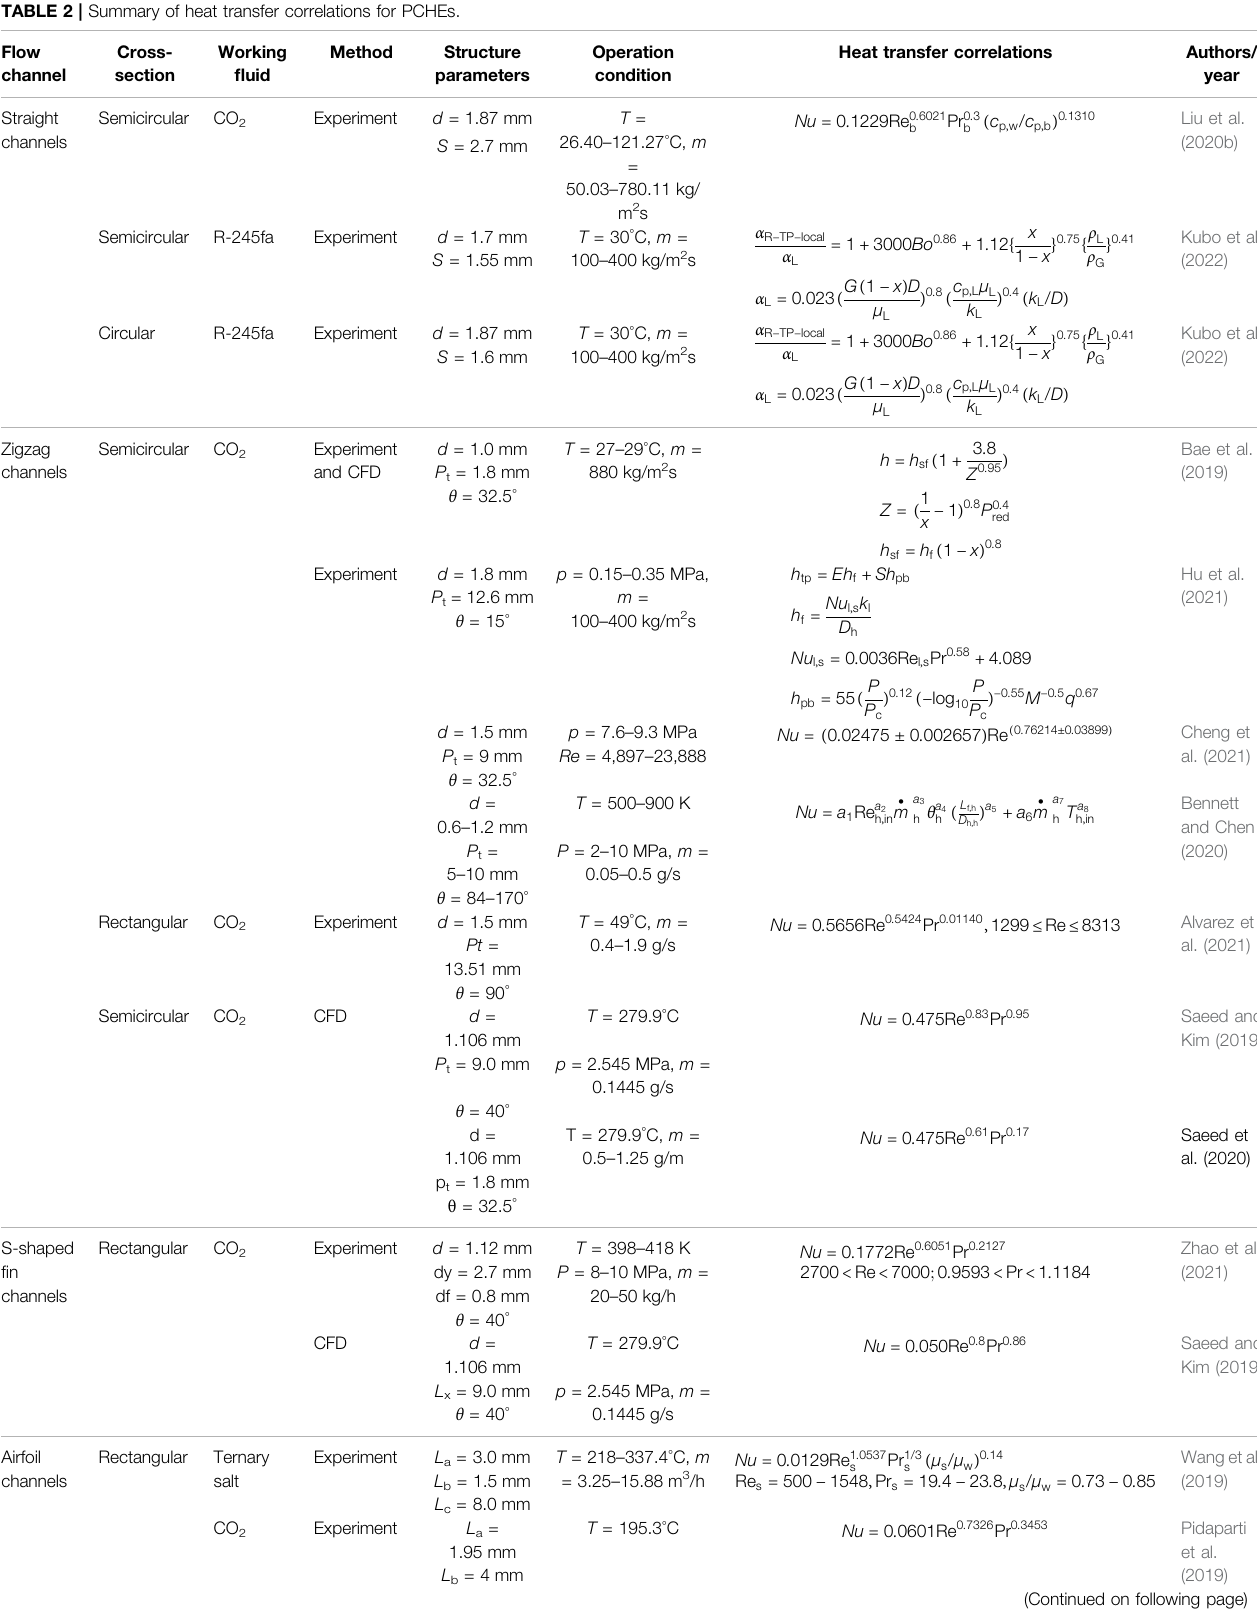
TABLE 2 | Summary of heat transfer correlations for